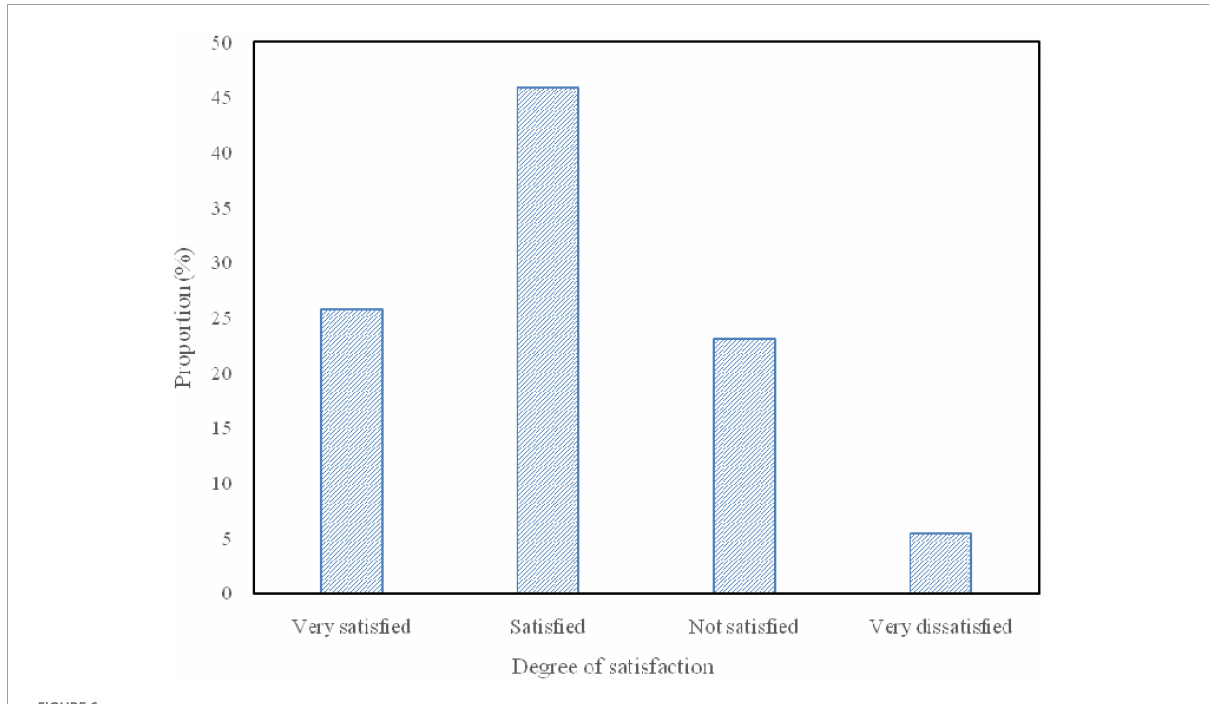
FIGURE6 Statistical chart of the satisfaction data of the first major course